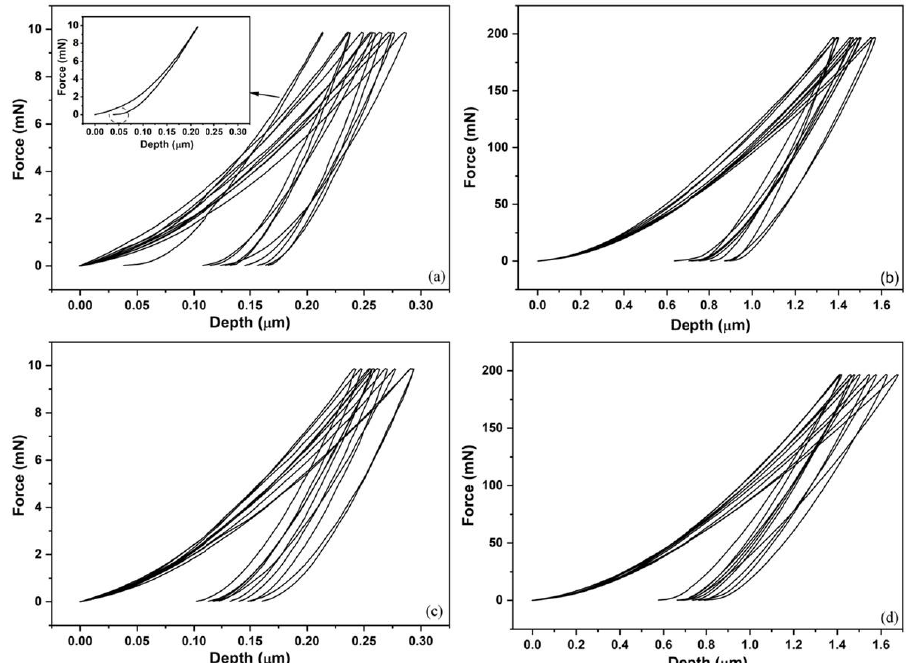
Figure 7. Force vs. depth (loading and unloading curves). ( a , b ) MW sample and ( c , d ) CS sample; maximum forces of 1.0 gf/9.81 mN and 20.0 gf/196.1 mN, respectively.